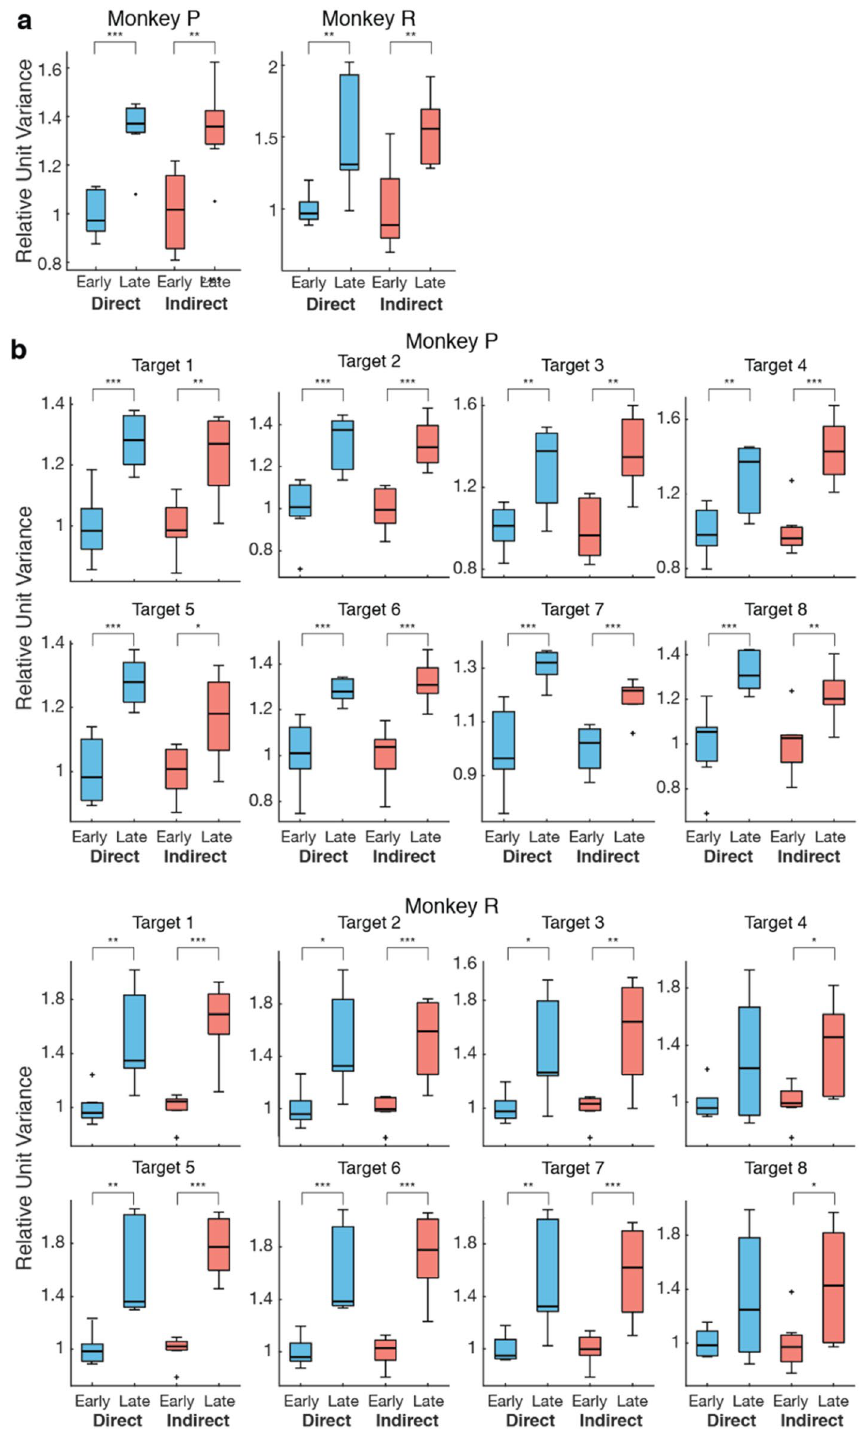
Figure 2. Neural variance increases with learning Variance was calculated for each neuron and then averaged across neurons. Relative variance was calculated by normalizing to the mean early variance within subpopulation. ( a ) Both direct and indirect subpopulations increased relative neural variance from early to late learning (Unpaired t-test; Monkey P: direct p = 8.63e-5, indirect p = 0.002; Monkey R: direct p = 0.007, indirect p = 0.003). ( b ) Analysis was repeated within target. Both direct and indirect subpopulations increased relative neural variance from early to late learning within target (Unpaired t-tests results reported in Table